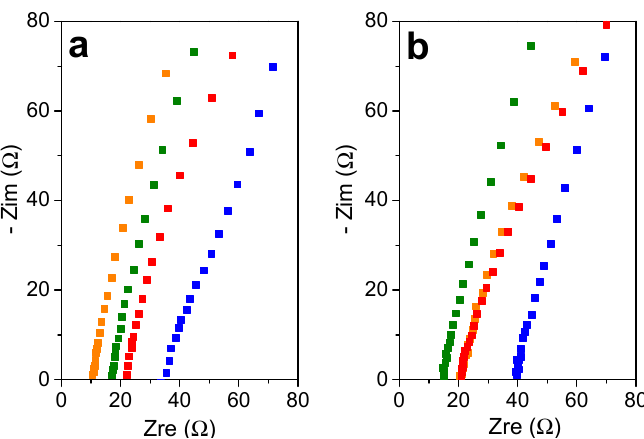
Figure 10. Nyquist diagram of triazole gel (in blue), triazolium + / TFSI − gel (in green), Triazolium + / I − gel (in red), and triazolium + / PF6 − (in orange). The gels were swollen with ( a ) LiPF 6 (1M) in EC / DEC (1 / 1) and ( b ) LiTFSI (1M) in EC / DEC (1 / 1). The cells were composed of stainless steel | PTMA gel | stainless steel.